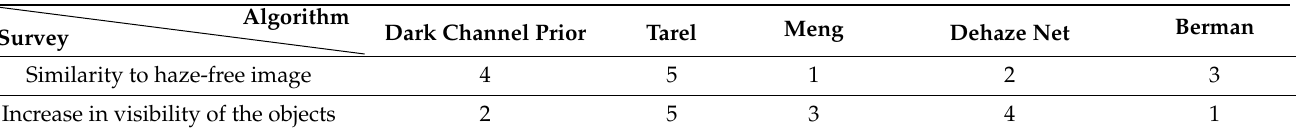
Table 3. Dehazing algorithms comparison from human subjects’ point of view. Medium haze conditions are considered. The table presents the ranking (from 1 to 5). Data from the table are extracted from [89]. Algorithm Dark Channel Prior Tarel Meng Dehaze Net Berman Survey Similarity to haze-free image Increase in visibility of the